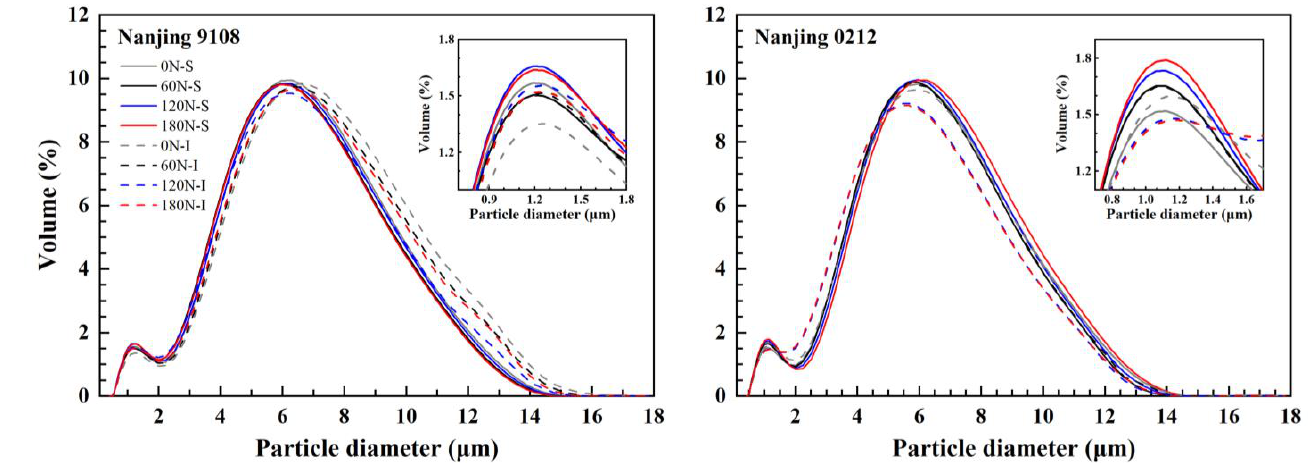
Figure 1. Starch granule size distributions of superior and inferior grains of japonica rice under different PNF treatments.